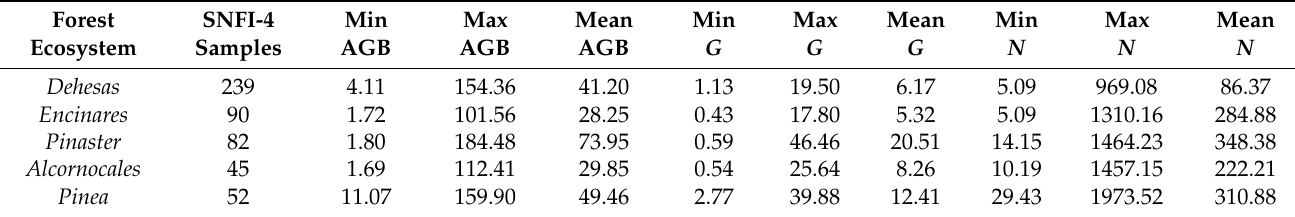
Table 3. Summary of ground data collected in the 4th National Forest Inventory (SNFI-4) for the five forest ecosystems. Plot-level estimates are presented for aboveground biomass (AGB, Mg ha − 1 ), stand basal area ( G , m 2 ha − 1 ), and tree density ( N , trees ha − 1